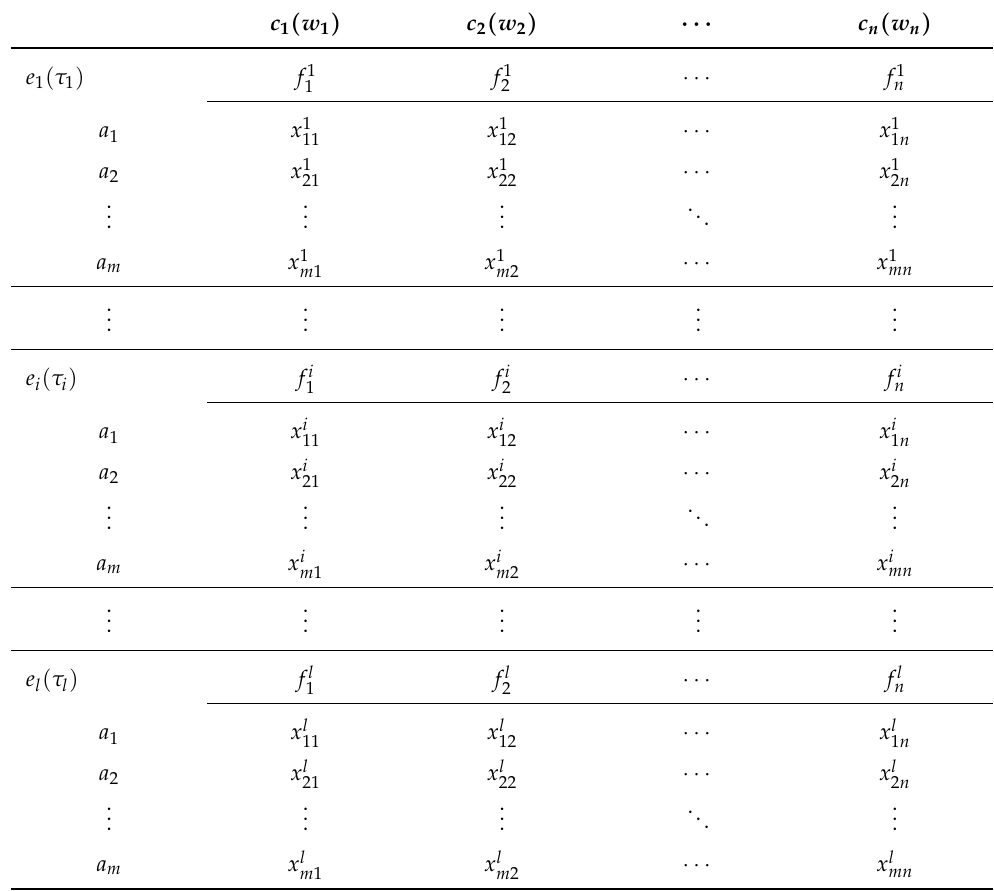
Table 4. The Chaotic MAGDM Information